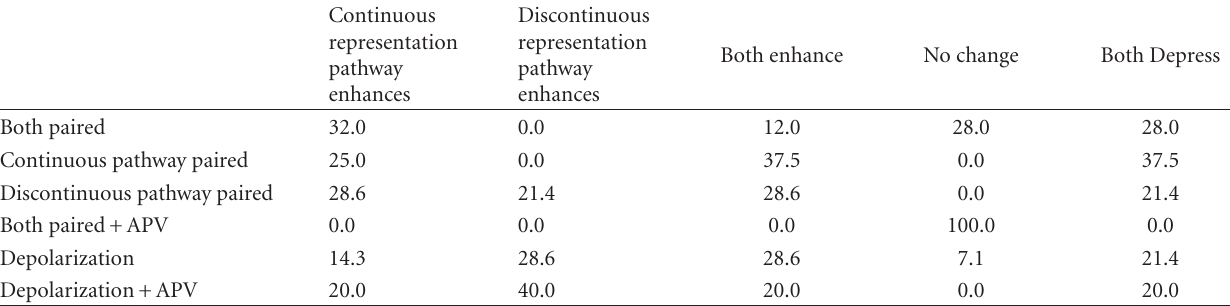
Table 2: Summary of results for LTP changes in amplitude (% occurring for each